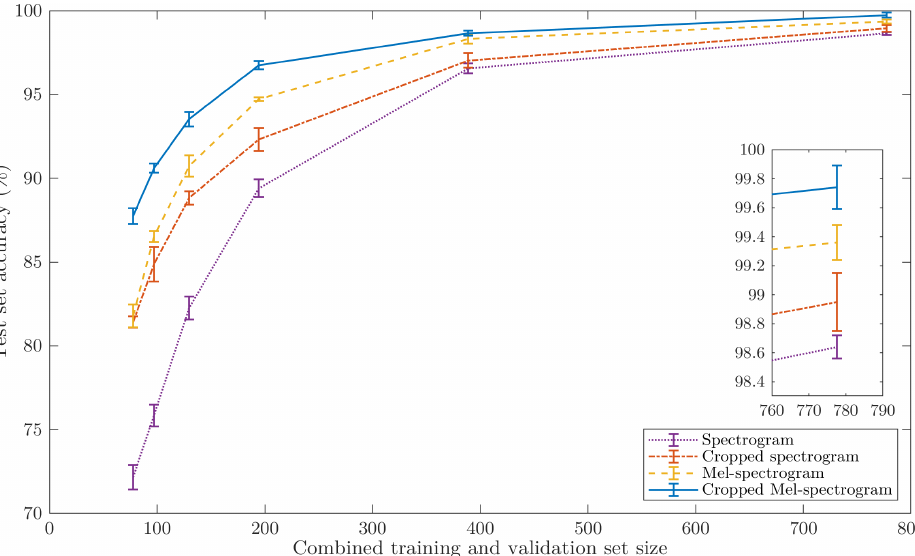
Figure 6. A depiction of the five-fold cross-validation procedure used to compare the four pre- processing techniques at six sample sizes. m represents the fraction of the data set used in the five-fold cross-validation, A is the accuracy obtained for each split, ¯ A is the mean accuracy of all five splits, σ is the associated standard deviation, N split is the total size of that split of the training data set and N test is the test set size.